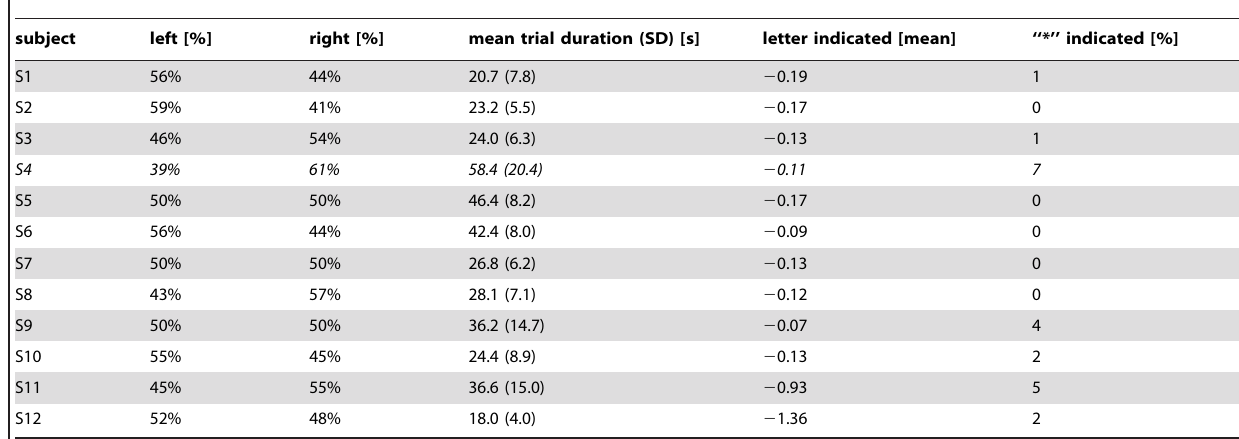
Table 1. Behavioural